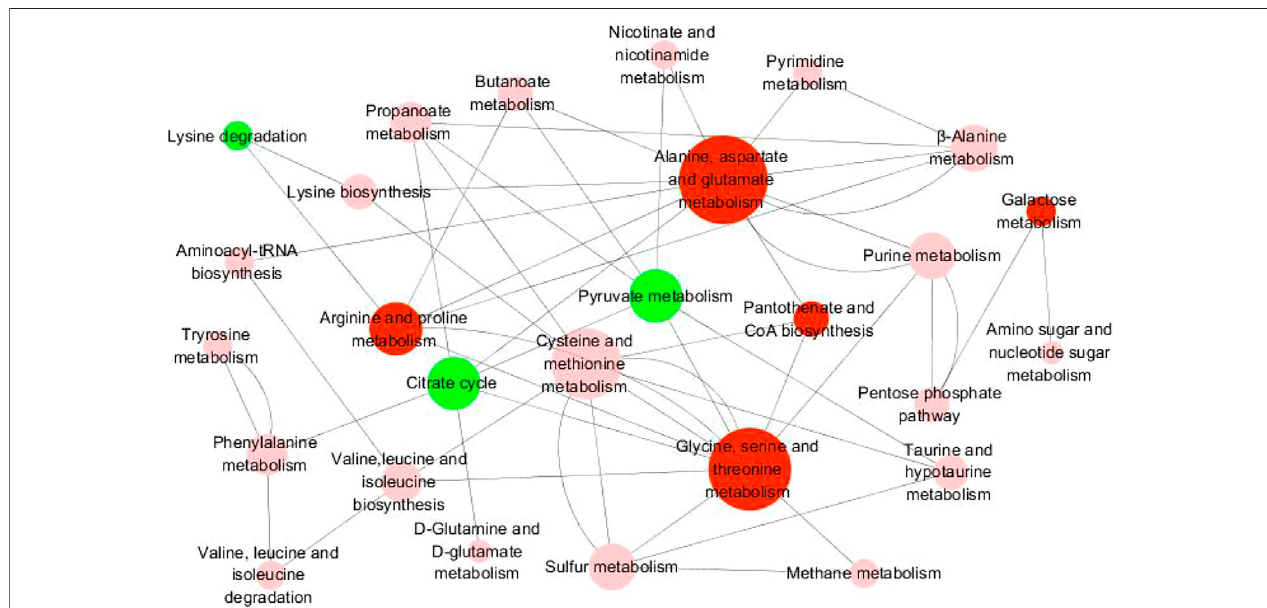
FIGURE 8 | Diagram of metabolic pathway interaction network. The pathway analysis was performed with Kyoto Encyclopedia of Genes and Genomes (KEGG) database (http://www.kegg.jp/kegg) and the picture was generated by Cytoscape. The bigger node represents more pathways connection. Red nodes represent pathway impact factors greater than 0.1 (Pathway impact > 0.1), green nodes represent pathway impact factors greater than 0.05 (Pathway impact > 0.05), and pink nodes represent pathway impact factors less than 0.05 (Pathway impact < 0.05).